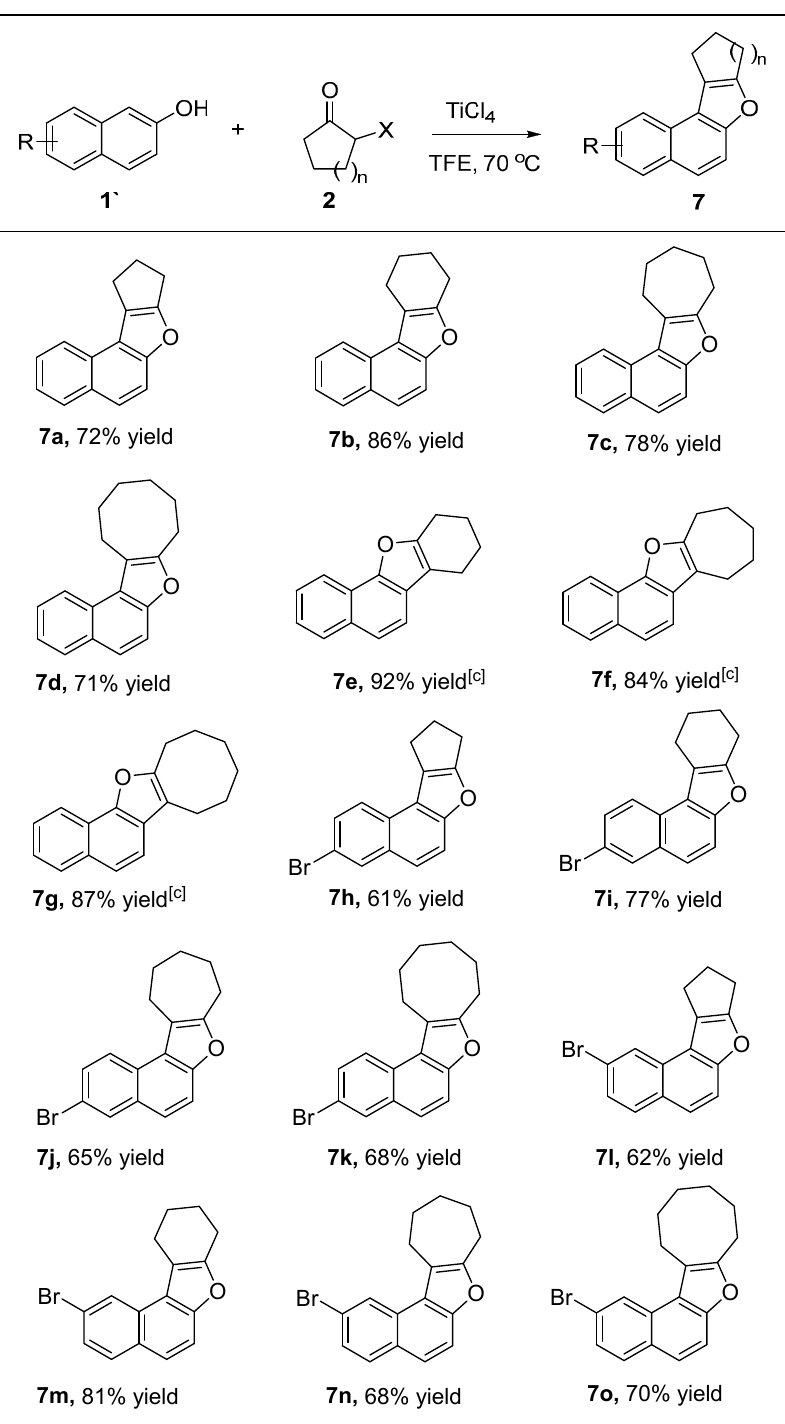
Molecules 2019 , 24 , x FOR PEER Table 3. Reaction of naphthols with di ff erent cyclic α -haloketones a, b .